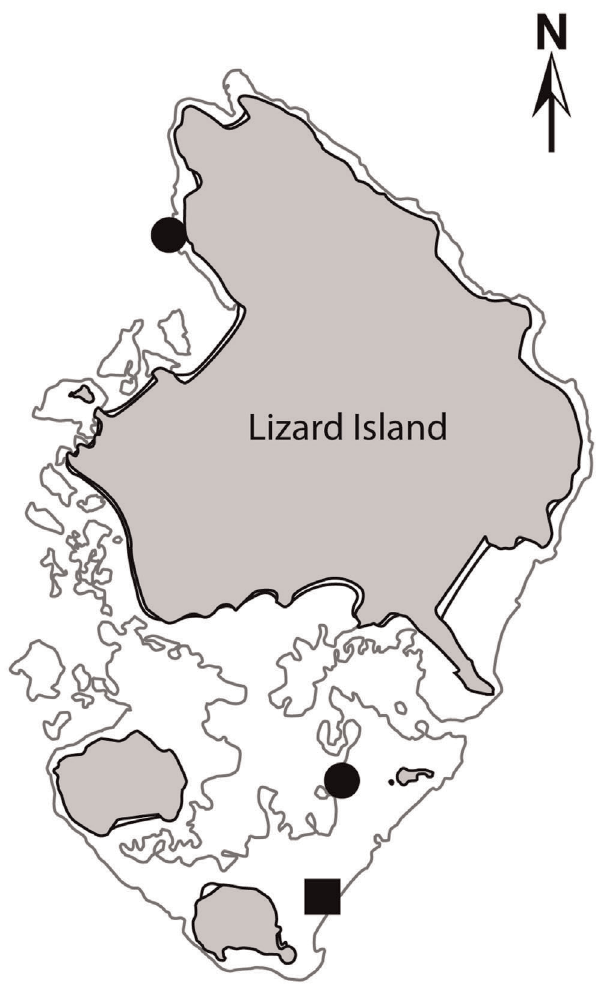
Figure 1. Site map. The filled square represents the location of the sediment removal study, where green turtles ( Chelonia mydas ) were observed feeding. The filled circle to the north represents the sheltered reef base and to the south the back reef. At both sites hawksbill turtles ( Eretmochelys imbricata ) were observed feeding on transplanted Sargassum